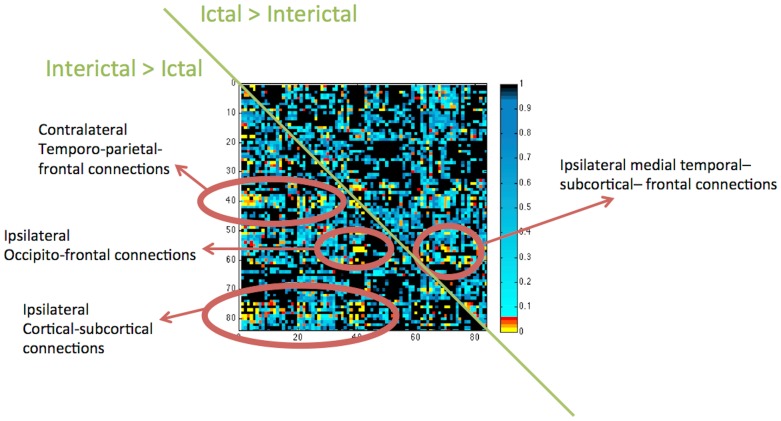
Statistical differences between the ictal and interictal state.These differences are displayed in a matrix of p-values. The row and column distribution is equivalent to the connectivity matrices displayed in previous figures (x-axis and y-axis ranging from regions 1 to 84). However, the upper triangular matrix represents the location were there was a significant ictal>interictal connectivity, while the lower triangular matrix represents interictal>ictal. These results are corrected for significant comparisons. The figure also highlights clusters of significant links with a legend to explain the corresponding anatomical location.